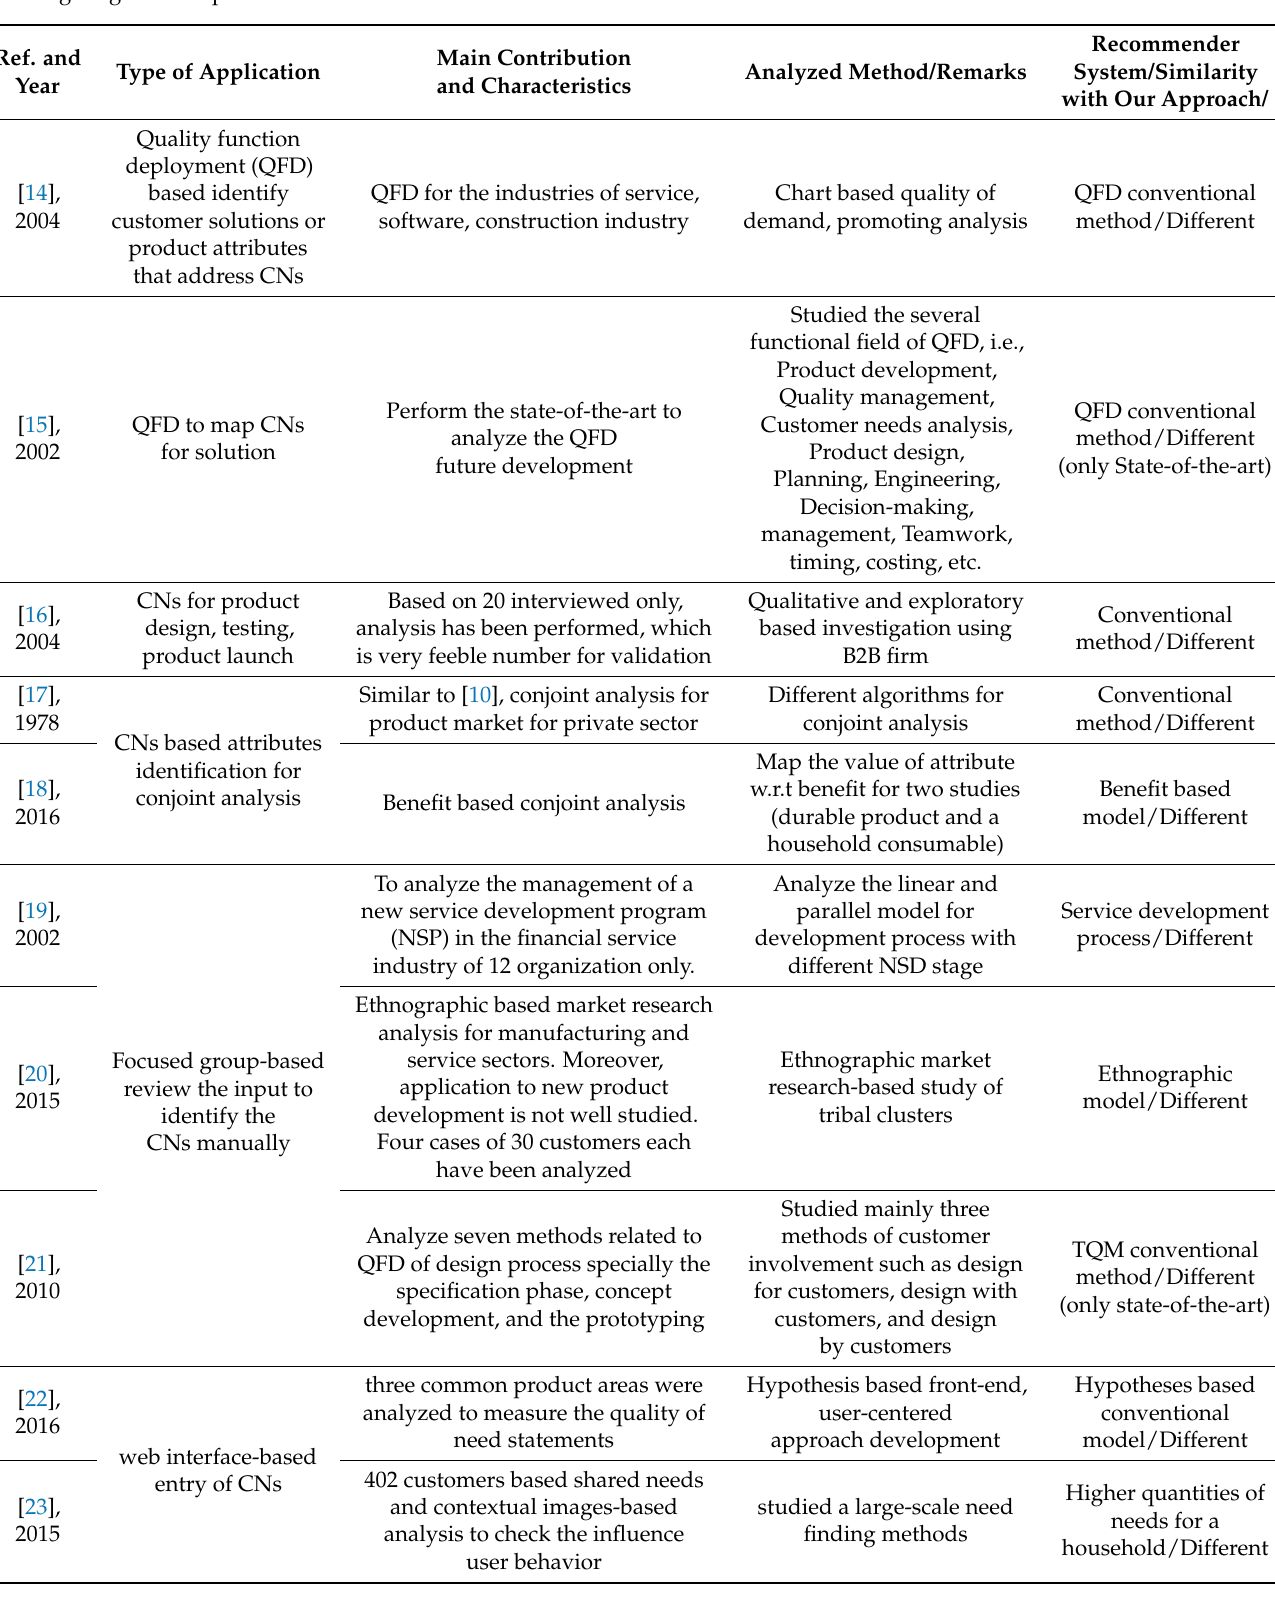
Table 2. Summary of the developed conventional methods for CNs analysis and their importance for product selection and targeting the new